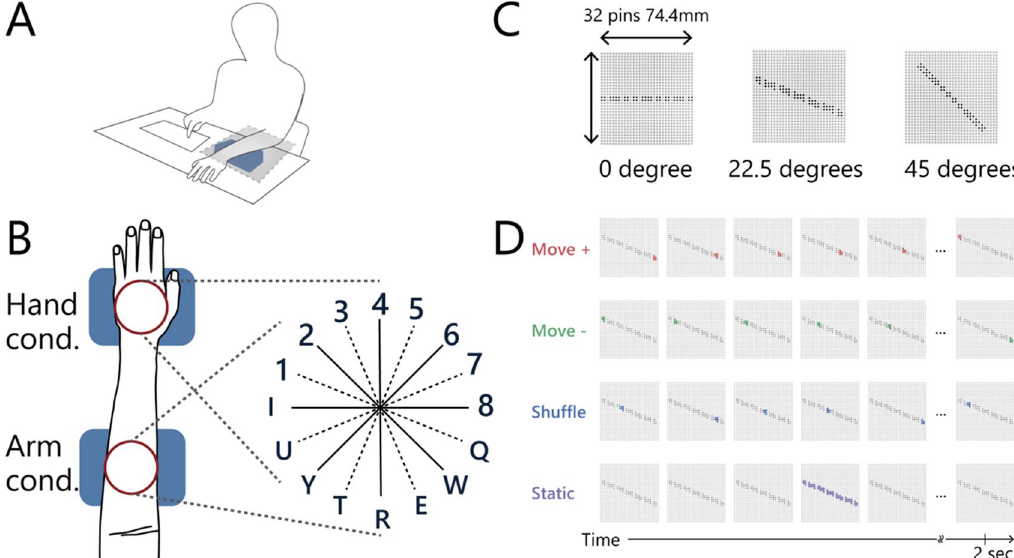
Figure 1. (A) View of the setup used in the experiments. The blue box represents the braille stimulator. The gray shaded area represents an occluder placed between the participants’ view and the stimulator. (B) The participants reported the perceived angle (both ends) of the stimulus shape with respect to the stimulator surface by pressing two keys. The wheel illustrated on the right was displayed as a response map in front of the participants during the experiments. (C) Trajectory of the stimuli. Open circles represent pins that remained in the “off” position for the duration of the stimulus presentation (2 s), and closed circles represent pins that took the “on” position for 0.1 to 0.2 s at some point, depending on the stimulus dynamics. Due to the specifications of the braille stimulator, the pins were not in an exactly straight line under some angle conditions. (D) Time course of a 22.5° angle of stimulus under four stimulus dynamics. Black circles represent the stimulus trajectory, and coloured circles represent pins in the “on” position at that